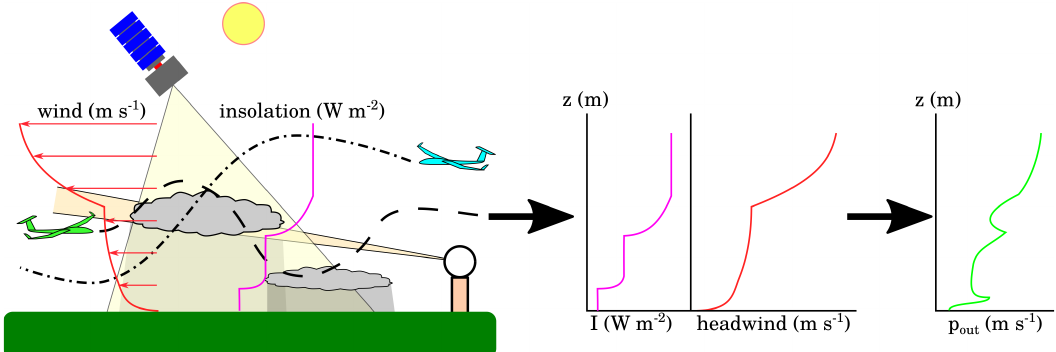
Figure 1. The aircraft environmental model should be able to be constructed onboard the aircraft from in situ observations but be able to incorporate observations from other platforms if available. It should model the atmospheric structure in a way that permits transformation into other quantities of